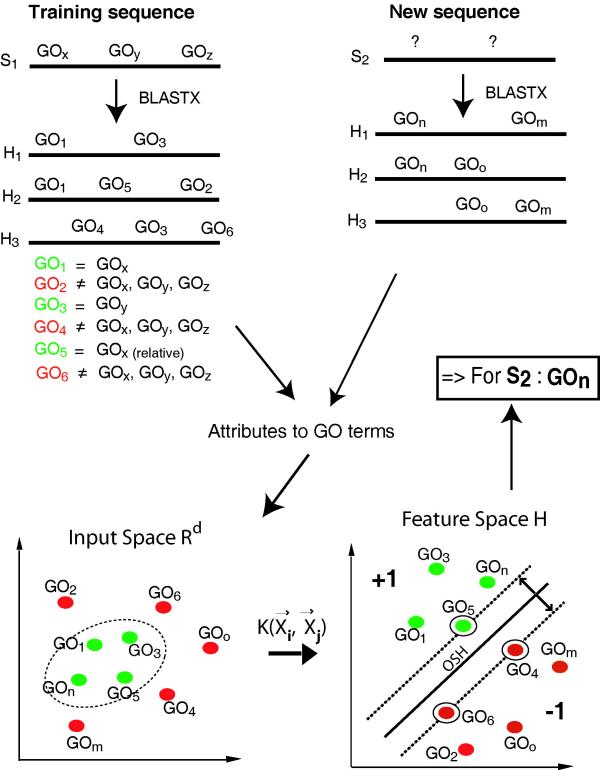
General prediction scheme: The training sequences (S1) with known function (GOx, GOy, GOz) were searched across the protein databases, yielding hits with molecular function GO terms (GO1, GO2, GO3, GO4, GO5, GO6) and their features (see methods), sketched as dots in a two-dimensional feature space. If GO terms of the hits compared to GO terms of the query, they were classified as +1 (correct, green), and -1 otherwise (red). The classifier (SVM) separated the classes by an optimal separating hyperplane (OSH). Unknown sequences (S2) were searched in the same manner and the GO terms (GOn, GOm, GOo) were extracted. Their features were calculated and mapped into the feature space. The corresponding labels were assigned (correct/false).